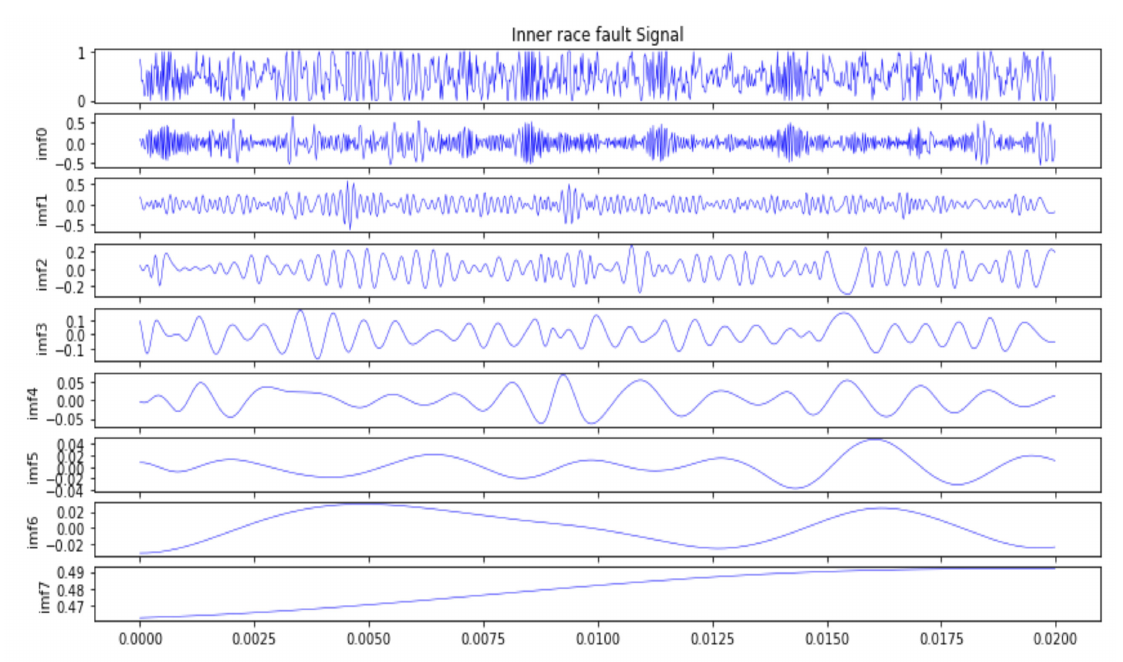
Figure 8. The decomposition results of inner race fault signal based on CEEMDAN.